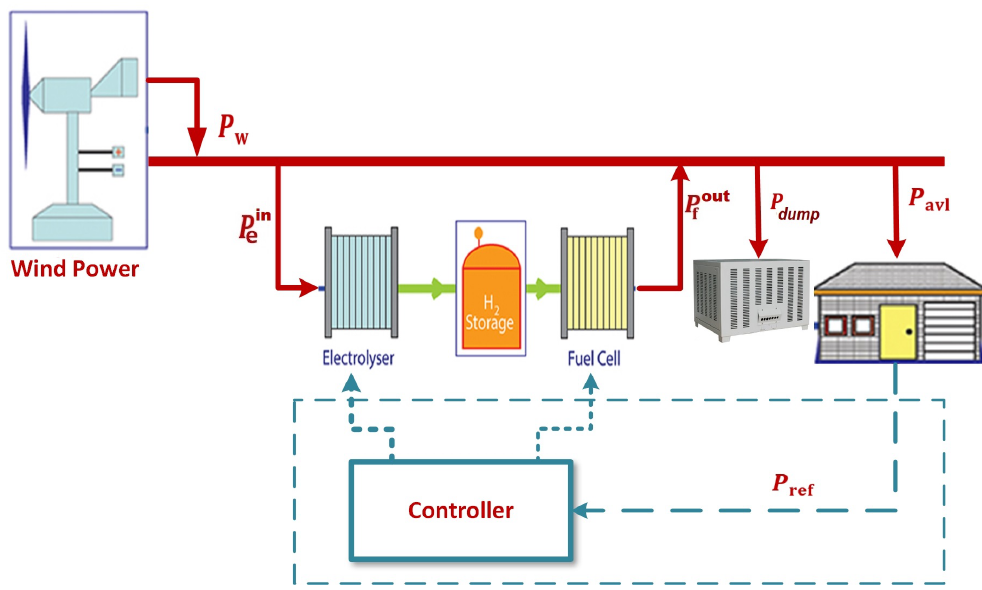
Figure 1. Block diagram of the microgrid under investigation. P w , P in e , P out